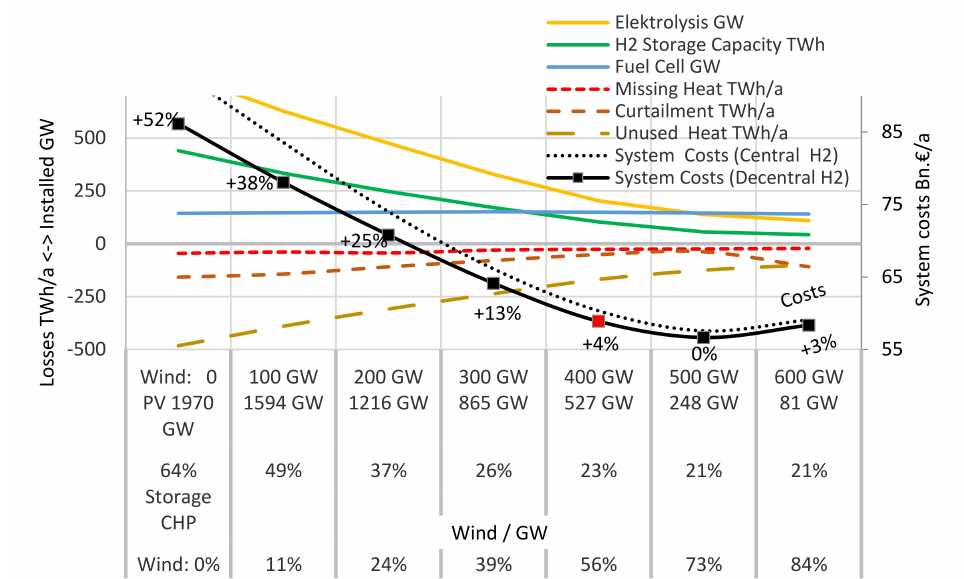
Figure 3. System costs (right axis) with and without Storage CHP (decentral) in a 100% renewable all-electric Germany for various wind shares. The red dot marks the standard scenario, with 400 GW wind used in the following